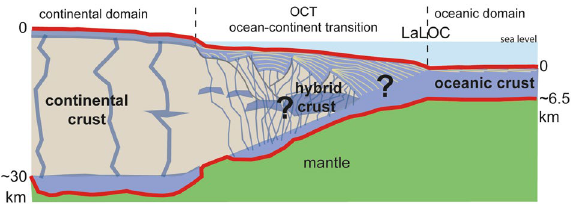
Figure 1. Cartoon highlighting the architecture of the transition between continental domains and unambiguous oceanic crust at magma-rich margins. The nature of the crust in the OCT is highly debated. While seaward dipping reflectors (yellow lines) are easily recognized on seismic reflection images, the amount of magma products (in blue) in the OCT is unknown and fully magmatic crust 14 as well as exhumed continental crust 16 are inferred. Here we do not speculate on the nature of this transitional hybrid crust that might be highly intruded. We rather defined the landward limit of the oceanic crust (LaLOC) based on two indisputable reflectors observed on seismic reflection images: the top of basement and the Moho (red lines). Leaving the oceanic domain, the LaLOC is located where the top of the crust shallows while the base of the crust deepens. These two inflexion points mark the departure from the typical geometry of the oceanic crust, with the top of basement broadly parallel to the Moho, testifying steady-state seafloor